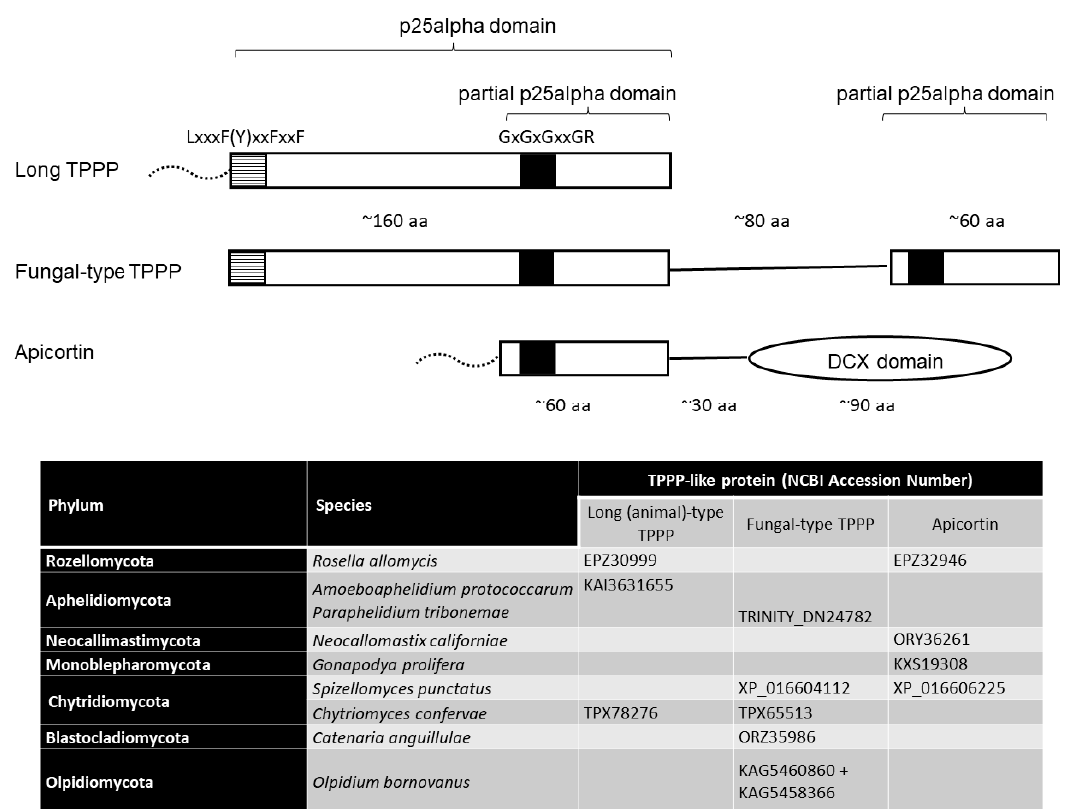
Figure 1. Schematic structure of TPPP-like proteins and their occurrence (selected examples) in non- terrestrial fungi ([6,9] and this paper). Black and dashed line squares indicate highly conservative sequence motifs. Dotted lines represent disordered regions of various length which are present in some species. aa- amino acids.